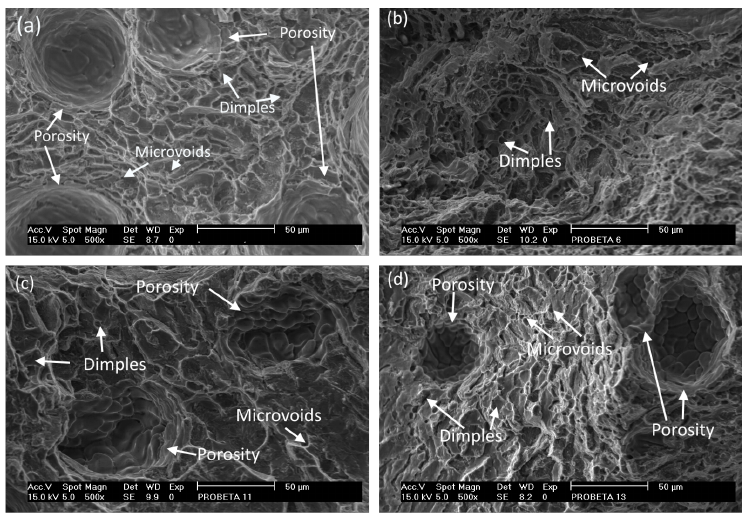
Figure 7. Micrographs in the fracture zone of selected samples of weld joints from AA6061–T6 alloy: ( a ) M2, and ( b ) M3; and weld joints from heat-treated alloy AA6061–T4: ( c ) M6, and ( d )